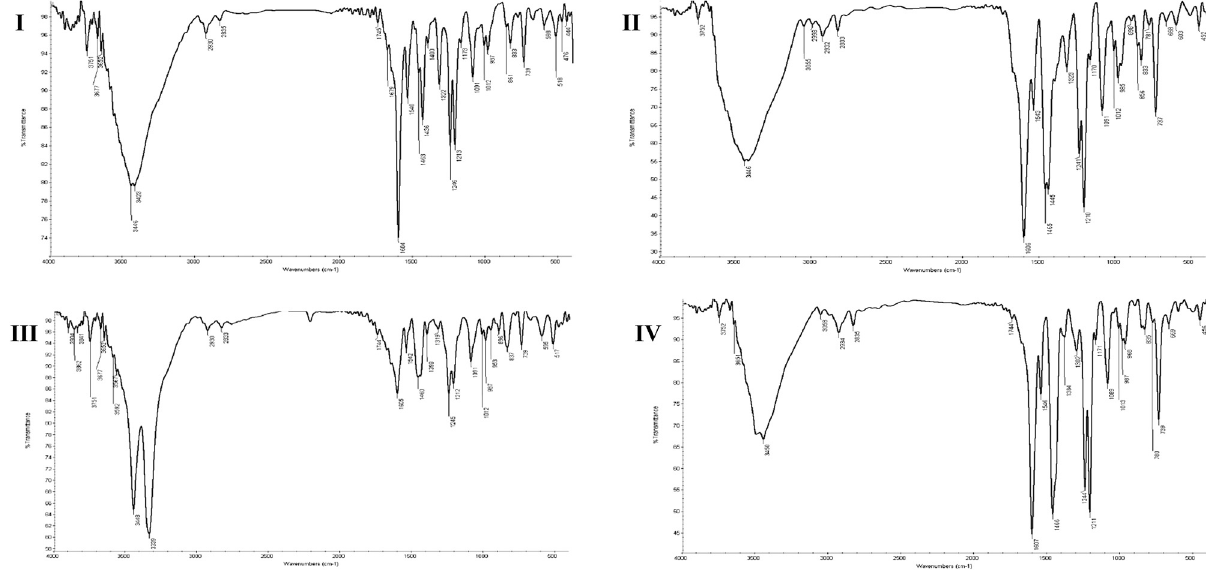
Figure 4: Infrared spectra of I: Co ( II ) , II: Ni ( II ) , III: Cu ( III ) , and IV: Zn ( II ) methoxy - diim